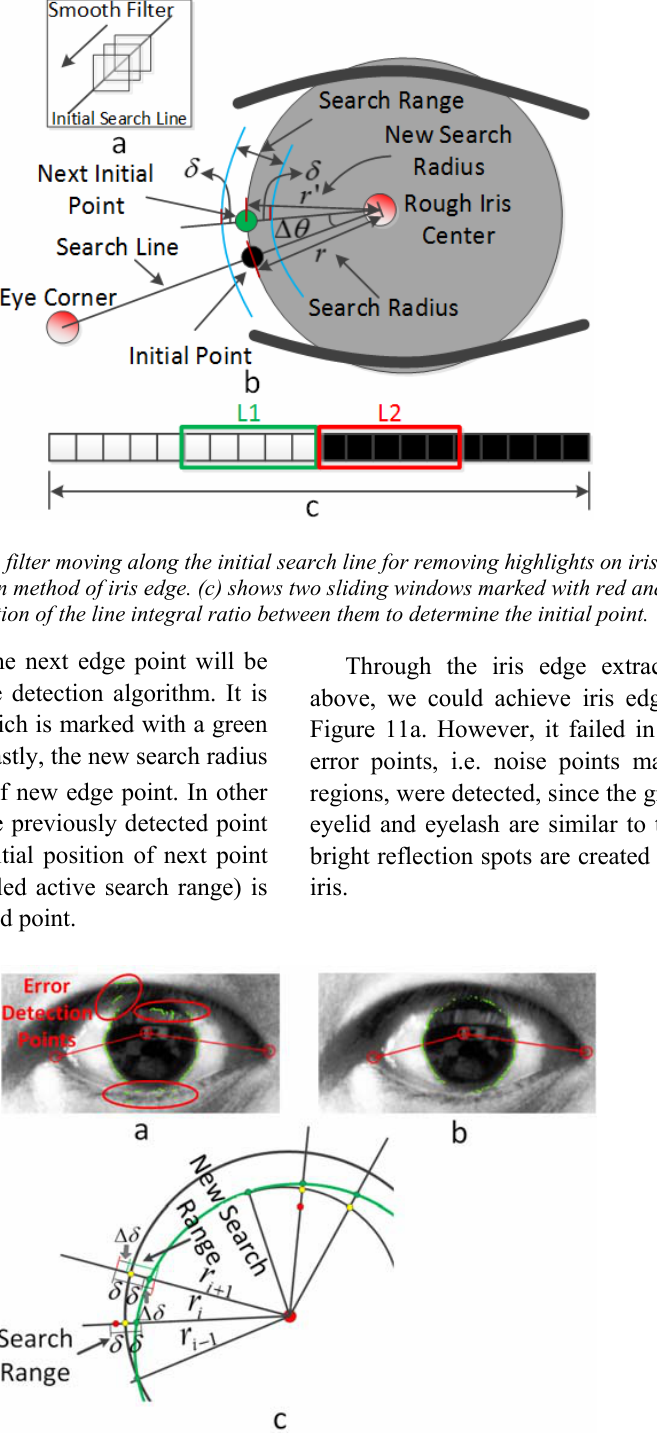
Figure 11: (a) shows detection result of edge points of iris. (b) shows detection result of edge points with the predicted edge points algorithm. (c) shows schematic diagram for Iris Edge Detection